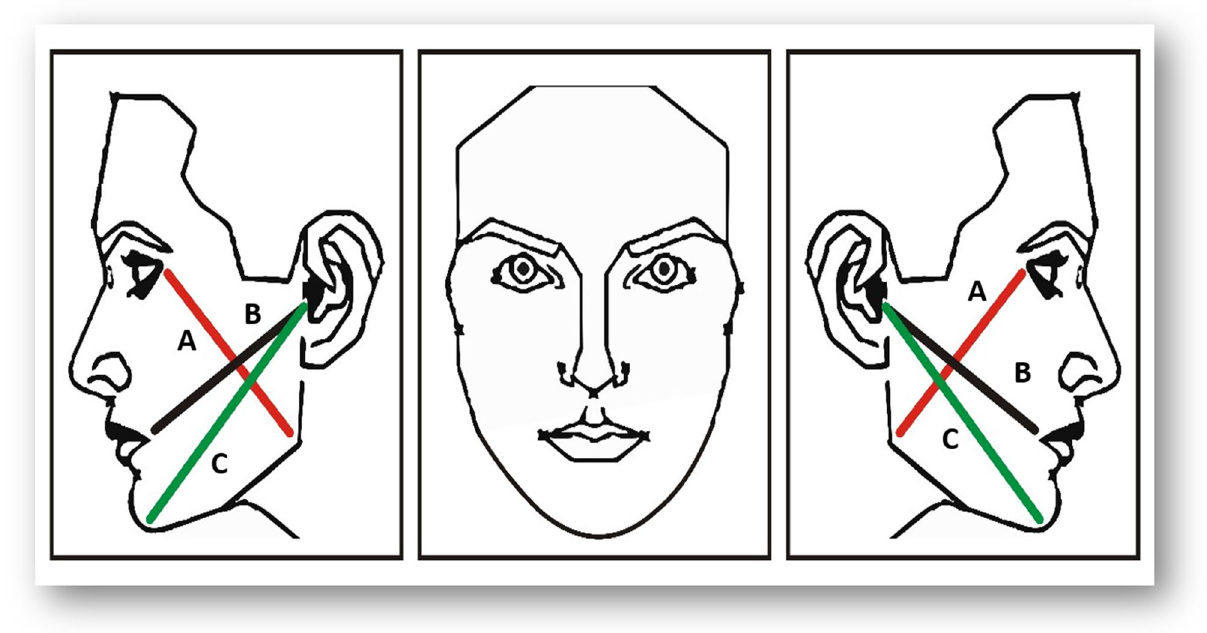
Figure 1. Representative scheme showing the topographic points measured for edema evaluation. The line A represented the point from mandibular angle up to corner of the eye. Line B represented the point from tragus up to labial commissure and line C represented the point from tragus up to pogonion. (CorelDRAW Graphics Suite X7.6- https:// www. corel draw.